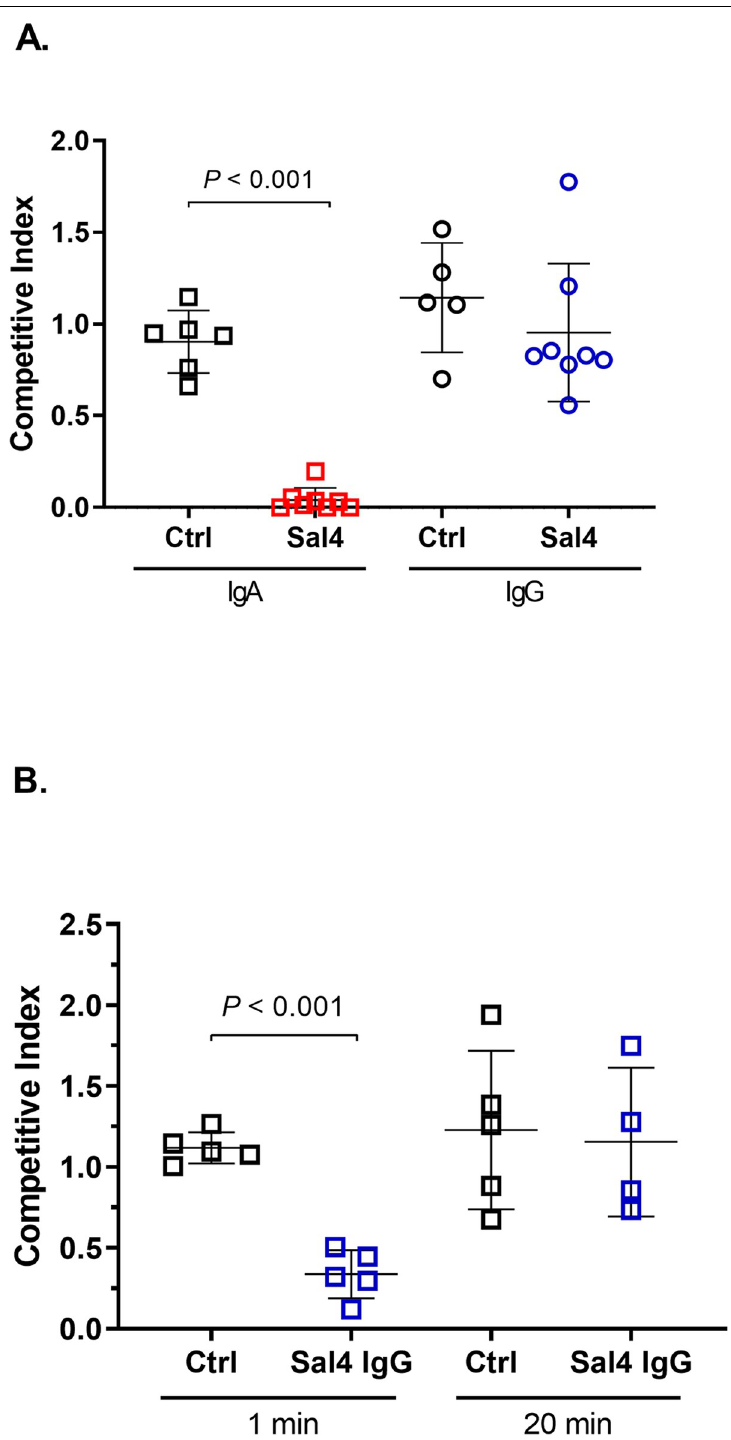
Fig 6. Sal4 IgG fails to inhibit STm invasion following oral infection in vivo , but can be partially rescued upon stabilization. BALB/c females were orally challenged with a competitive index of wildtype (AR05) and oafA mutant (AR04) STm (4 x 10 7 CFUs) either (A) pre-incubated with 30 μ g/mL of antibody in PBS or (B) administered antibody prior to STm challenge at the indicated time points with sodium bicarbonate and protease inhibitors. 24 hours (p.i.) mice were euthanized and Peyer’s patches were harvested and enumerated for CFUs and competitive indices. Statistical significance evaluated for each group over the isotype control, as determined by unpaired Student’s t -test ( n = at least 5 mice per